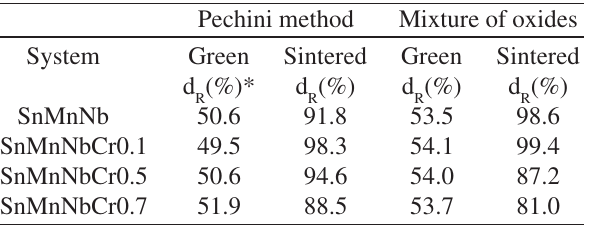
Table 3. Relative density (d pacts at 1300 °C for 3 h.